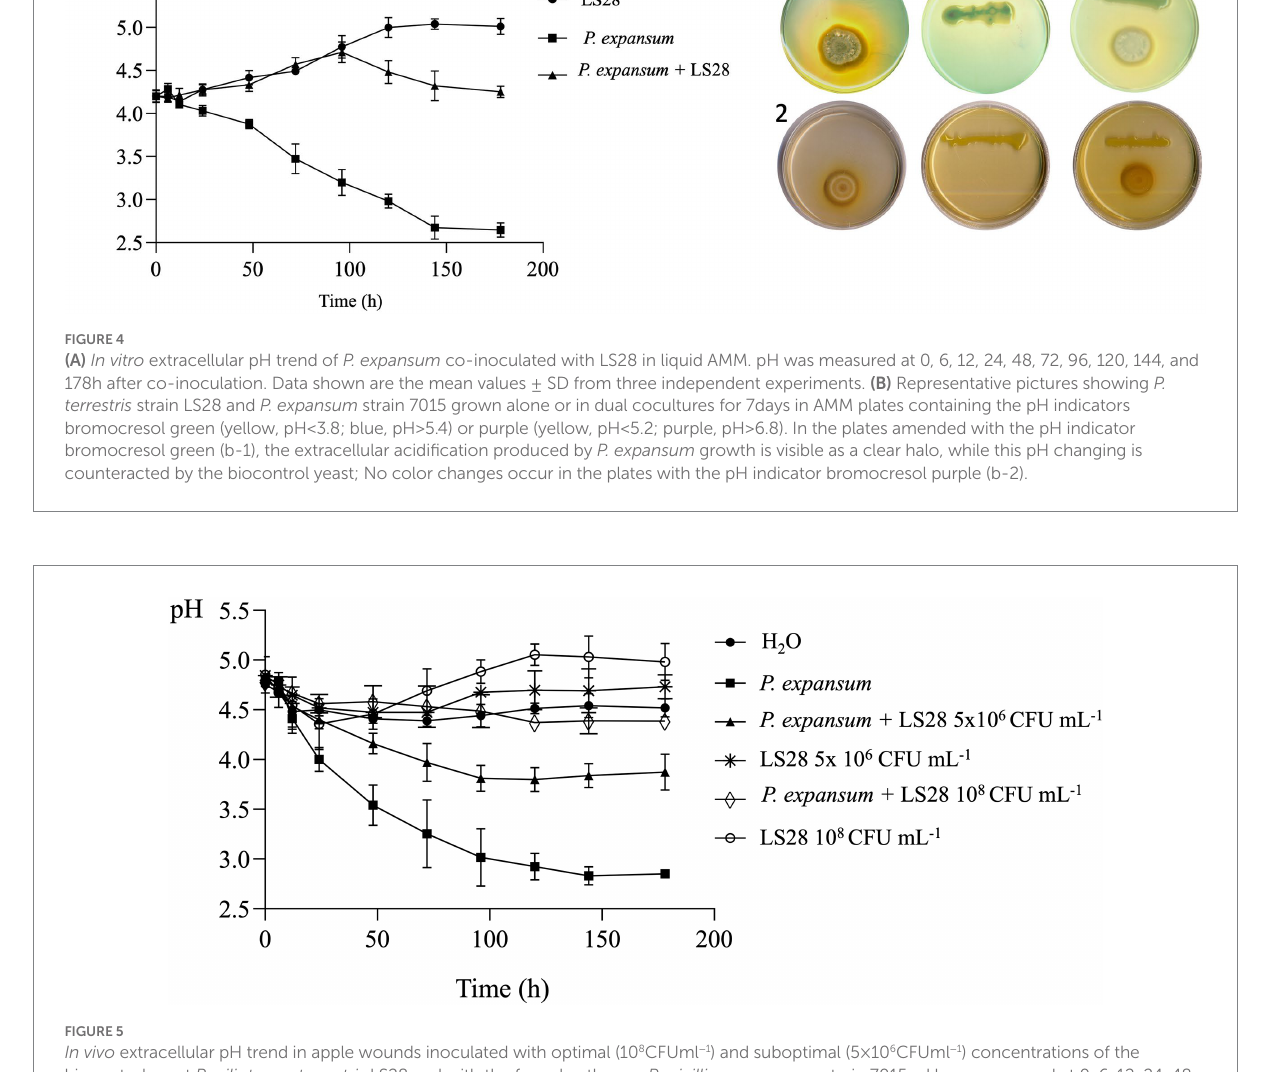
the BCA induces a more pronounced alkalinization, with pH